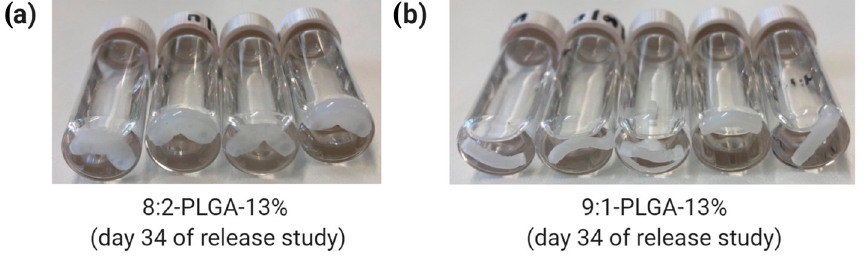
Figure 5. Comparison of water uptake by ( a ) 8:2 and ( b ) 9:1 PLGA implants on day 34 of the release study, where the former exhibits a higher degree of swelling due to higher GL composition.